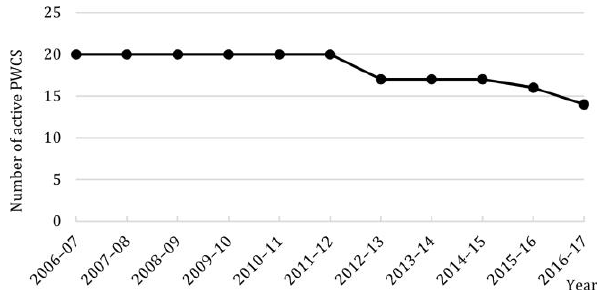
Fig. 6. Year wise production in Chinsurah division (Source: Handloom Development Office, Chinsurah, 2017)